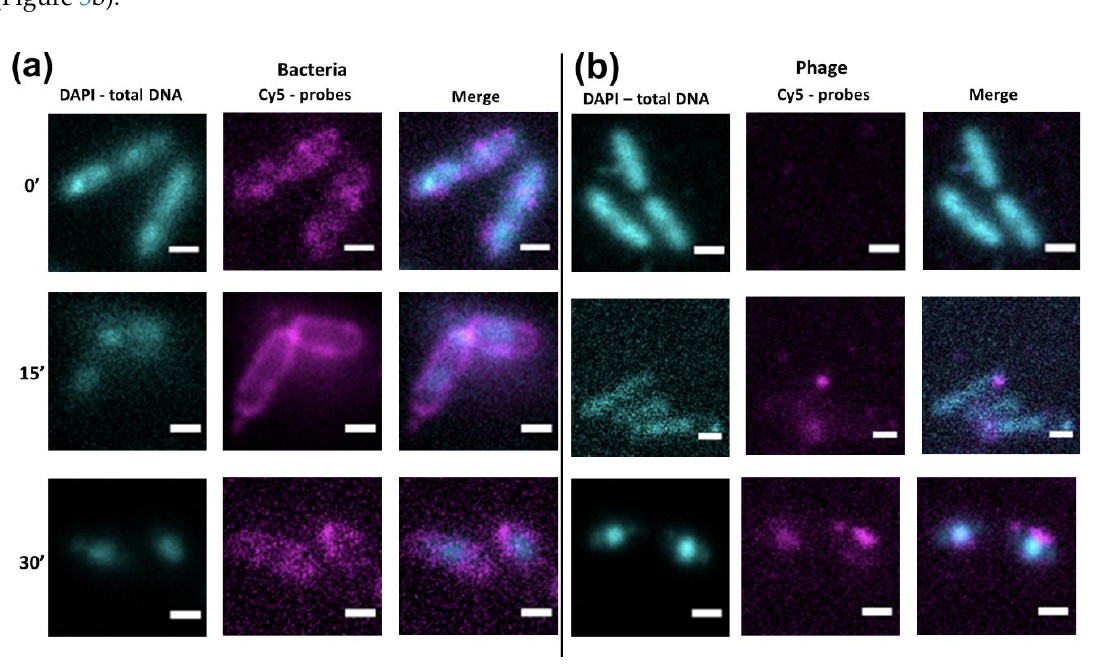
Figure 5. Analysis of bacterial and phage DNA at different times before and after infection of P. aeruginosa cells by the phiKZ phage. Results of fluorescent in situ hybridization (FISH) ( a ) with bacterial Cy5-probes, ( b ) with phage Cy5-probes. DAPI signal—cyan color, Cy5 signal is colored magenta. Bar—1 um. Time points are indicated on the left.